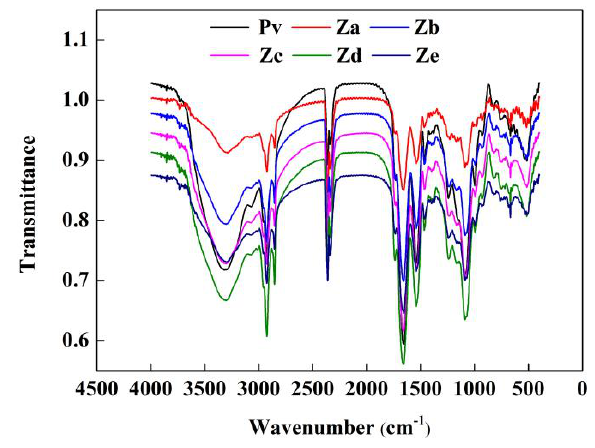
Figure 3 . FTIR of Pv–GA complexes . Figure 3. FTIR of Pv–GA